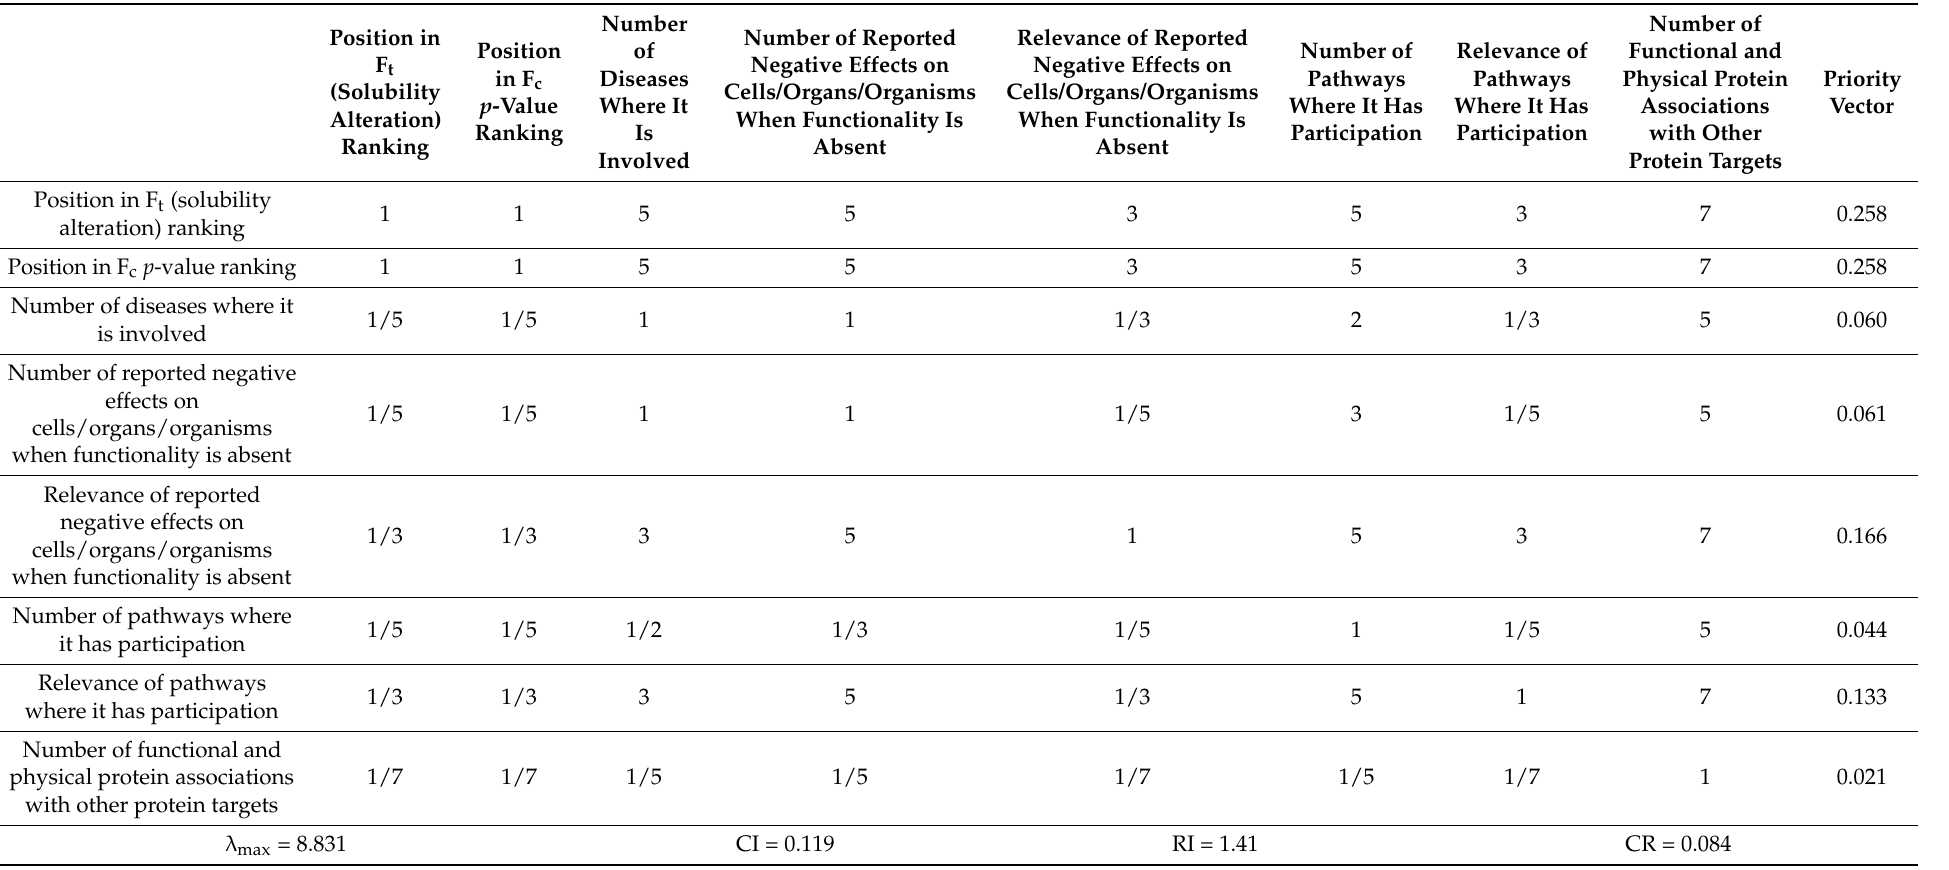
Table 3. Pairwise comparison matrix for the criteria at level 2 of the hierarchy and the computed values of priority vector, λ max , CI, RI, and